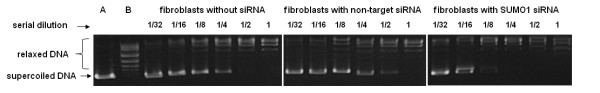
Catalytic function of topo I in cultured SSc fibroblasts with and without SUMO1 siRNA transfection. A serial dilution of the nuclear extract containing topo I obtained from SSc fibroblasts was used to relax 0.25 μg supercoiled DNA. In this figure, the supercoiled DNA band was completely transformed to relaxed DNA at dilutions of one half and one in the fibroblasts without siRNA transfection or non-target siRNA transfection. In contrast, this change was observed between the one-eighth and one-fourth dilutions in the fibroblasts with SUMO1 transfection, which indicates a higher efficiency of catalytic function of topo I after SUMO1 inhibition in the fibroblasts. According to the intensity of the bands of remaining supercoiled DNA in serial dilutions in the assays of three fibroblast strains, these changes are significant. The P-values are 0.045 and 0.027 at the one-fourth dilution for comparisons between SUMO1 siRNA vs. non-target siRNA, or vs. without siRNA transfected fibroblasts, respectively (Student's t-test). This is representative of three SSc fibroblast strains examined in SUMO1 siRNA studies. *A, supercoiled DNA; B, relaxed DNA.